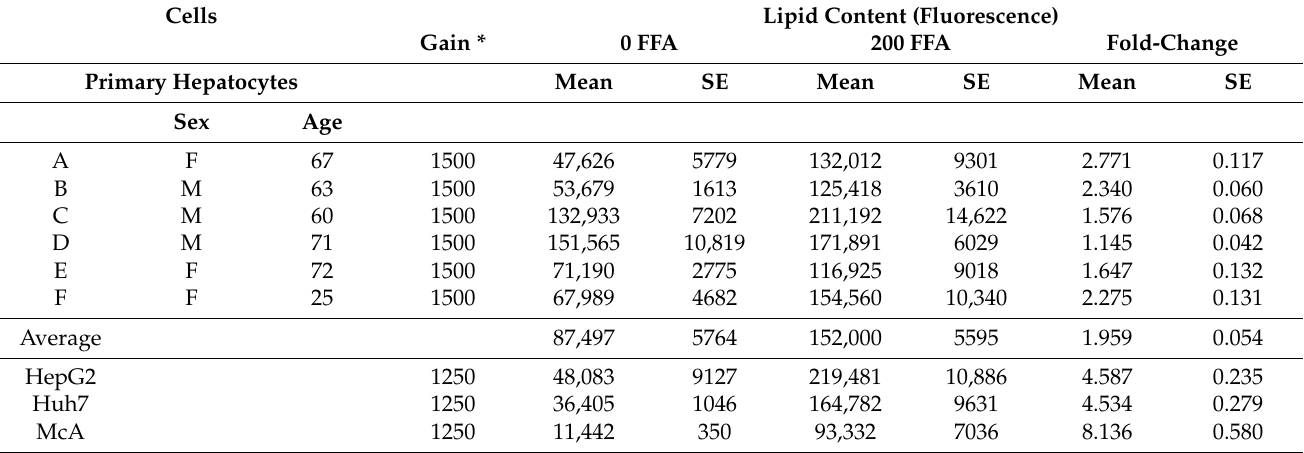
Table 1. Comparison of lipid content of different cell types in absence and presence of added fatty